Question: According to the figure, is the described quantity increasing or decreasing?
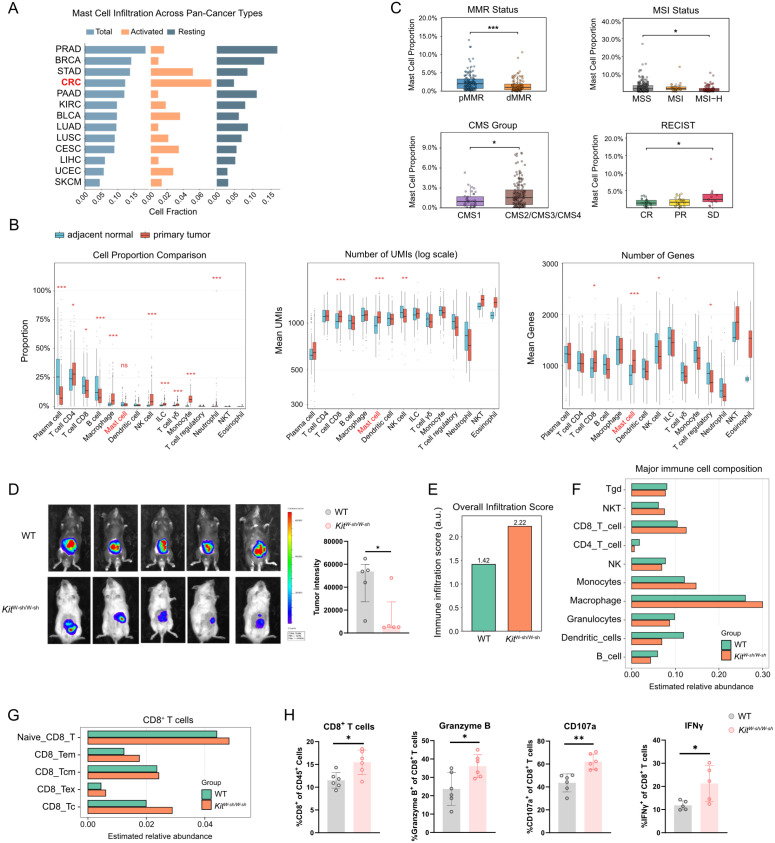
Answer: increasing